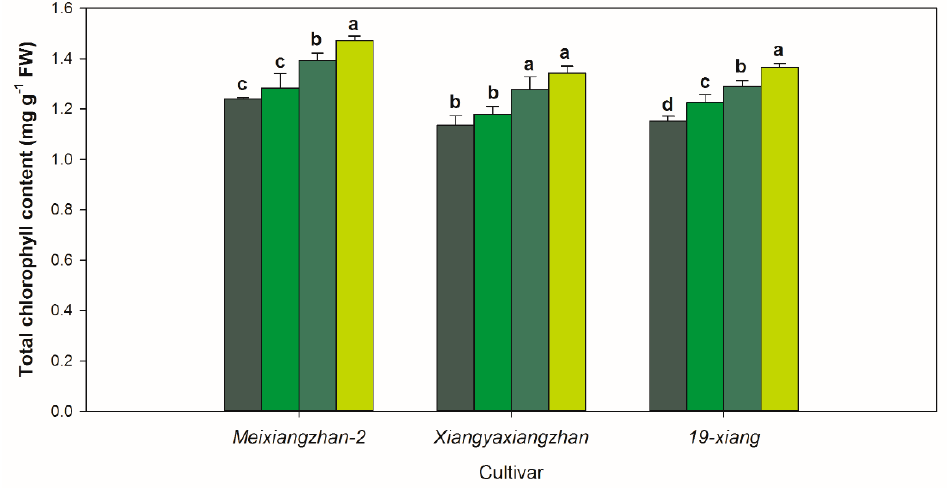
Figure 2. Effects of vermicompost incorporation on contents of chlorophyll a, chlorophyll b, carotenoid, and total chlorophyll of fragrant rice seedlings; those sharing a common letter do not differ significantly at p < 0.05 according to the least significant difference (LSD) test for three fragrant rice cultivars.